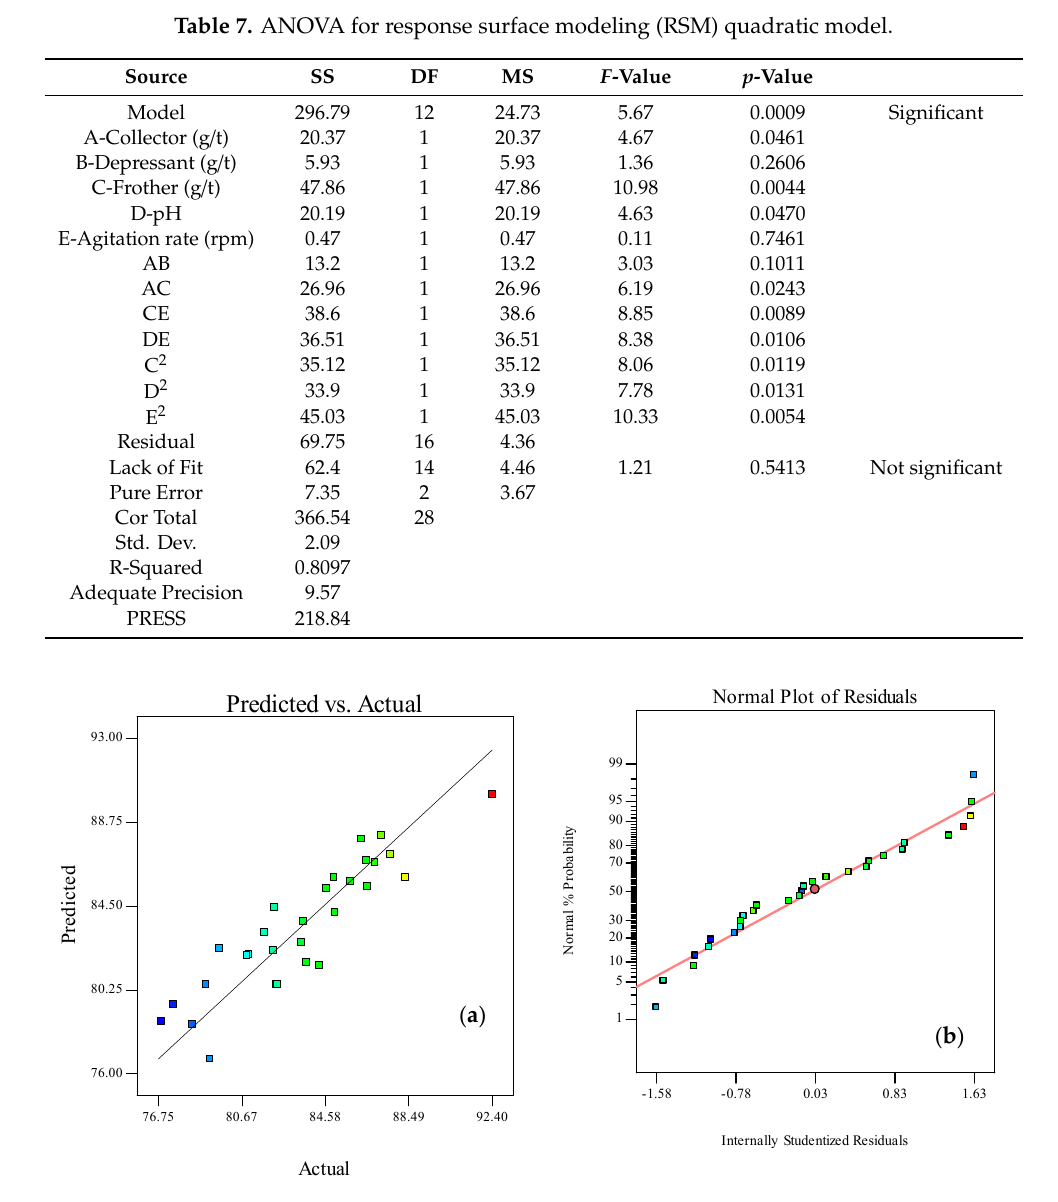
Figure 1. The plot of actual (measured) versus predicted values for copper recovery in ( a ) rougher flotation process and ( b ) plot of normal probability versus Studentized residual. Table 7. ANOVA for response surface modeling (RSM) quadratic model.